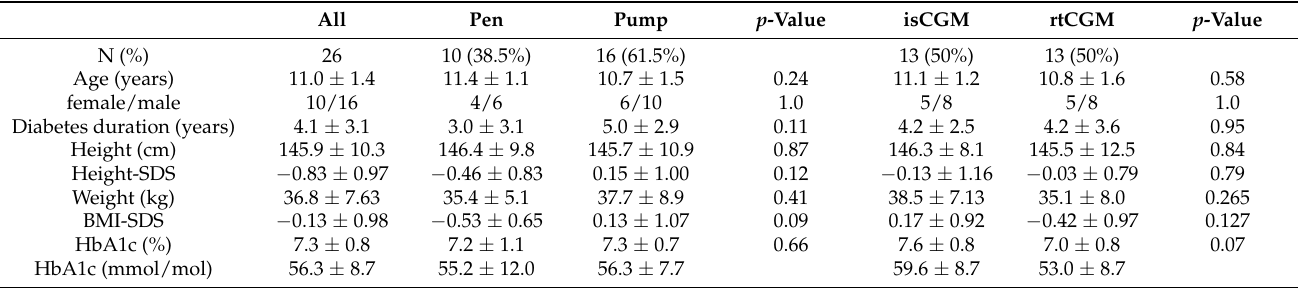
Table 1. Baseline Characteristics.